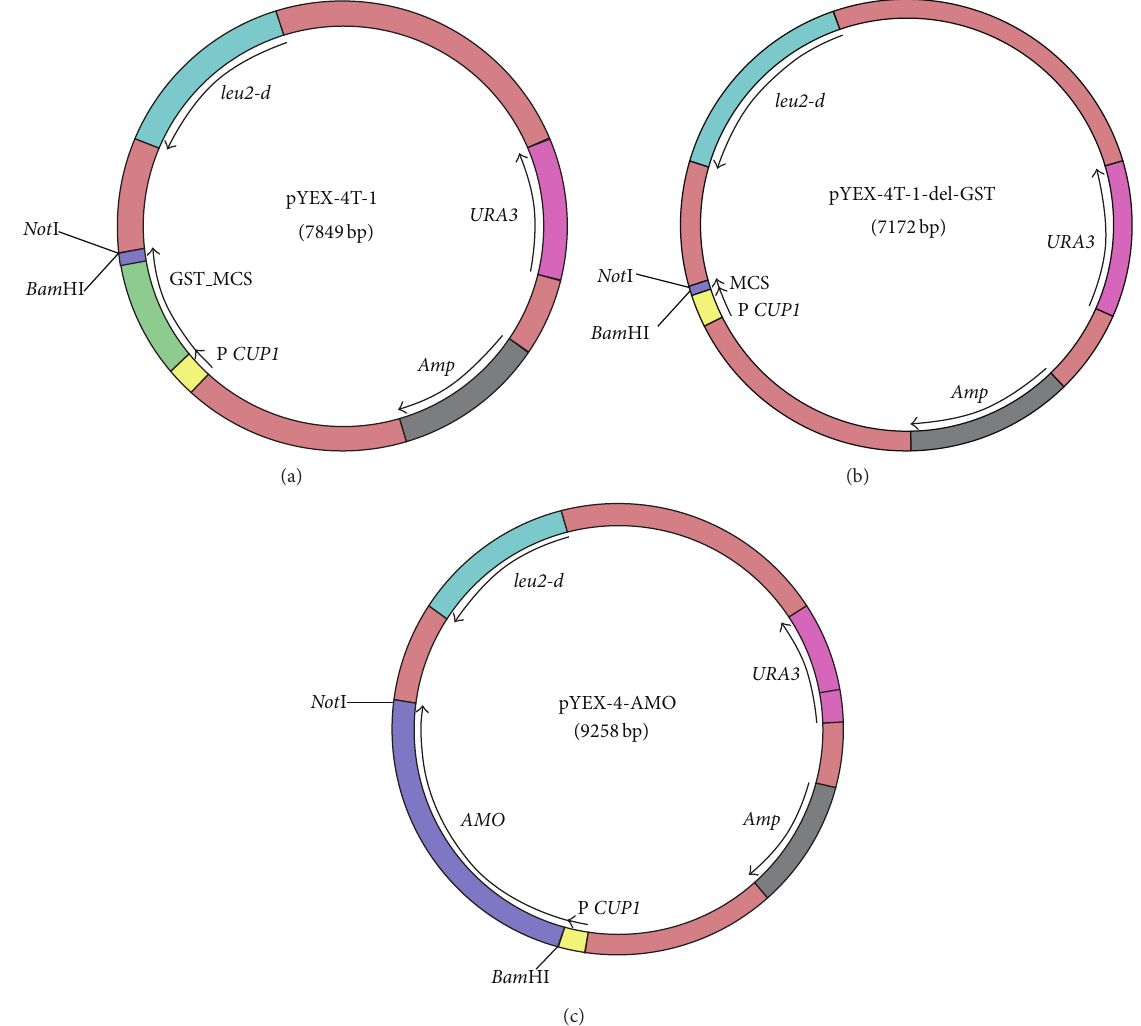
Figure 1: Cloning of the AMO gene into the expression vector